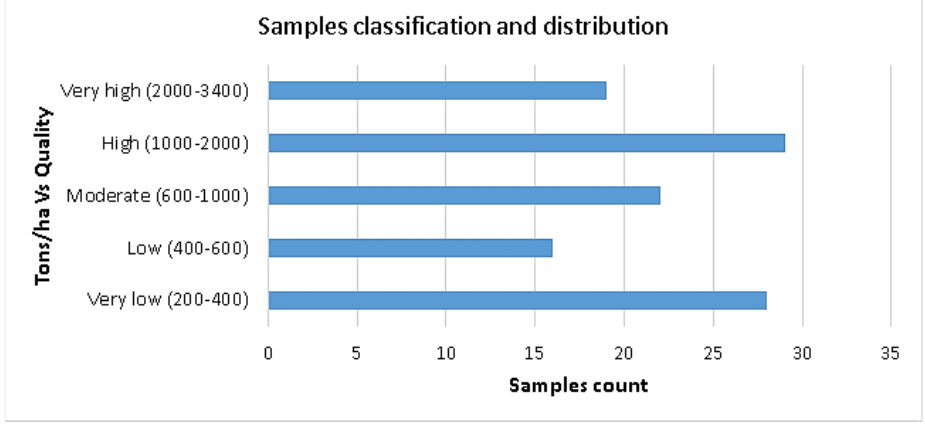
Figure 8. trees samples classification . Figure 8. Trees samples